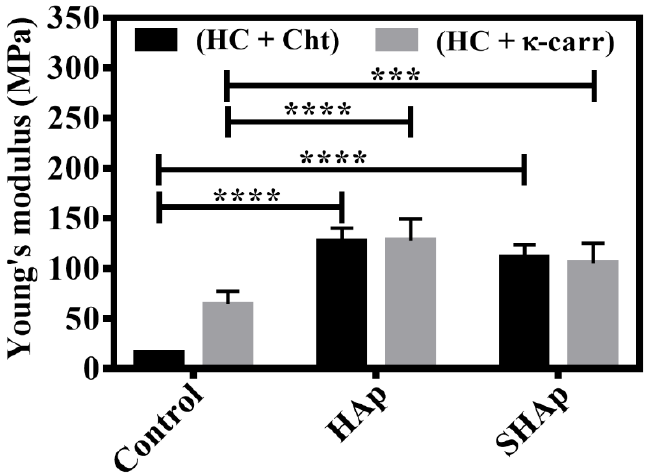
Figure 3. Mechanical properties of the biomembranes. Comparison of the Young’s modulus obtained for the membranes based on hydrolyzed collagen (HC) and chitosan (Cht), referred to as control, ((HC + Cht), (HC + Cht)_HAp, and (HC + Cht)_SHAp) and on hydrolyzed collagen (HC) and κ -carrageenan ( κ -carr) ((HC + κ -carr), (HC + κ -carr)_HAp, and (HC + κ -carr)_SHAp). Results represent the mean + SD for quintuplicate determination for one experiment. Multiple statistical comparisons were performed by two ‐ way ANOVA in relation to the control, **** p < 0.0001 and *** p = 0.0008.